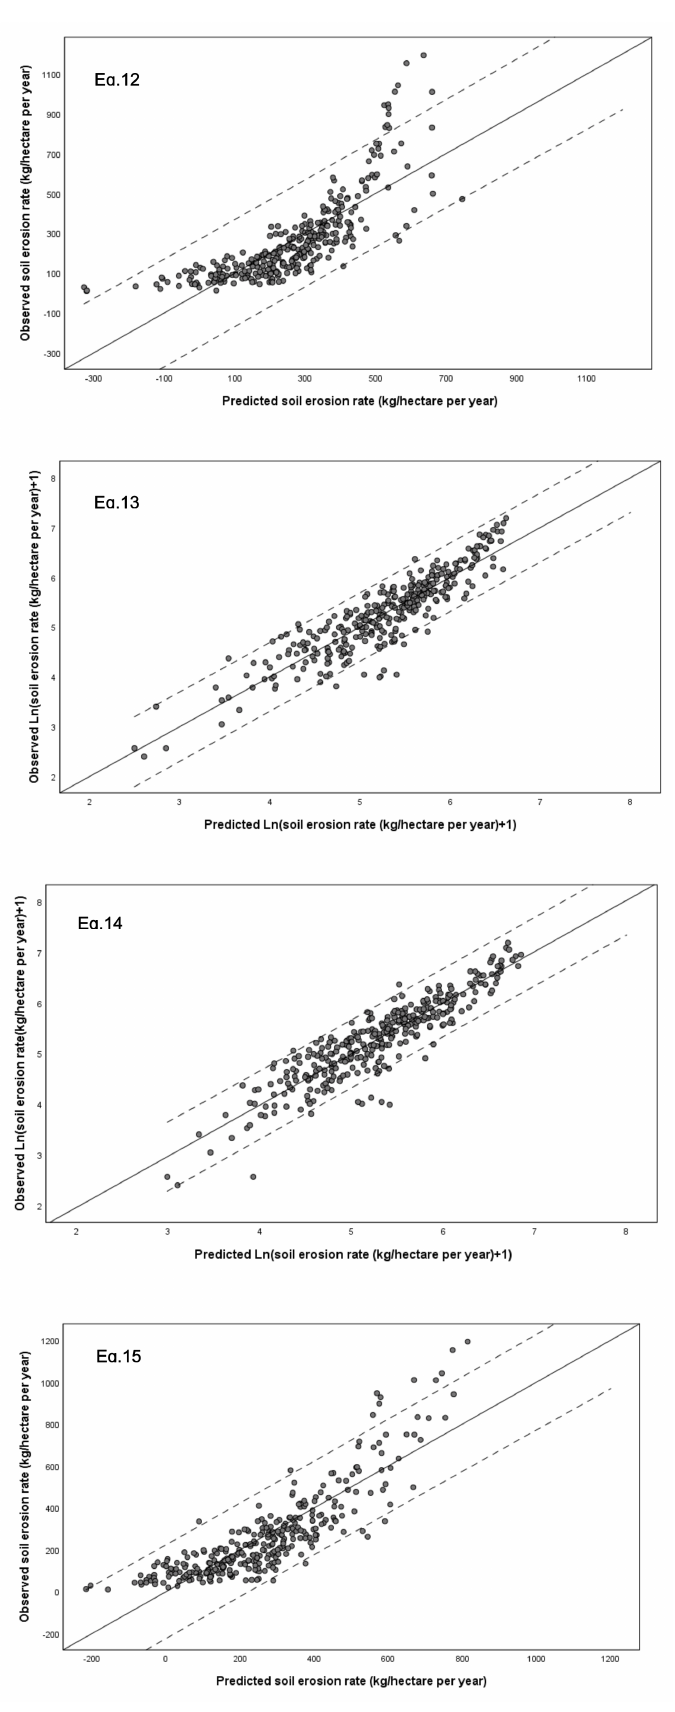
Figure 2. One-to-one diagrams for predicted values versus observed